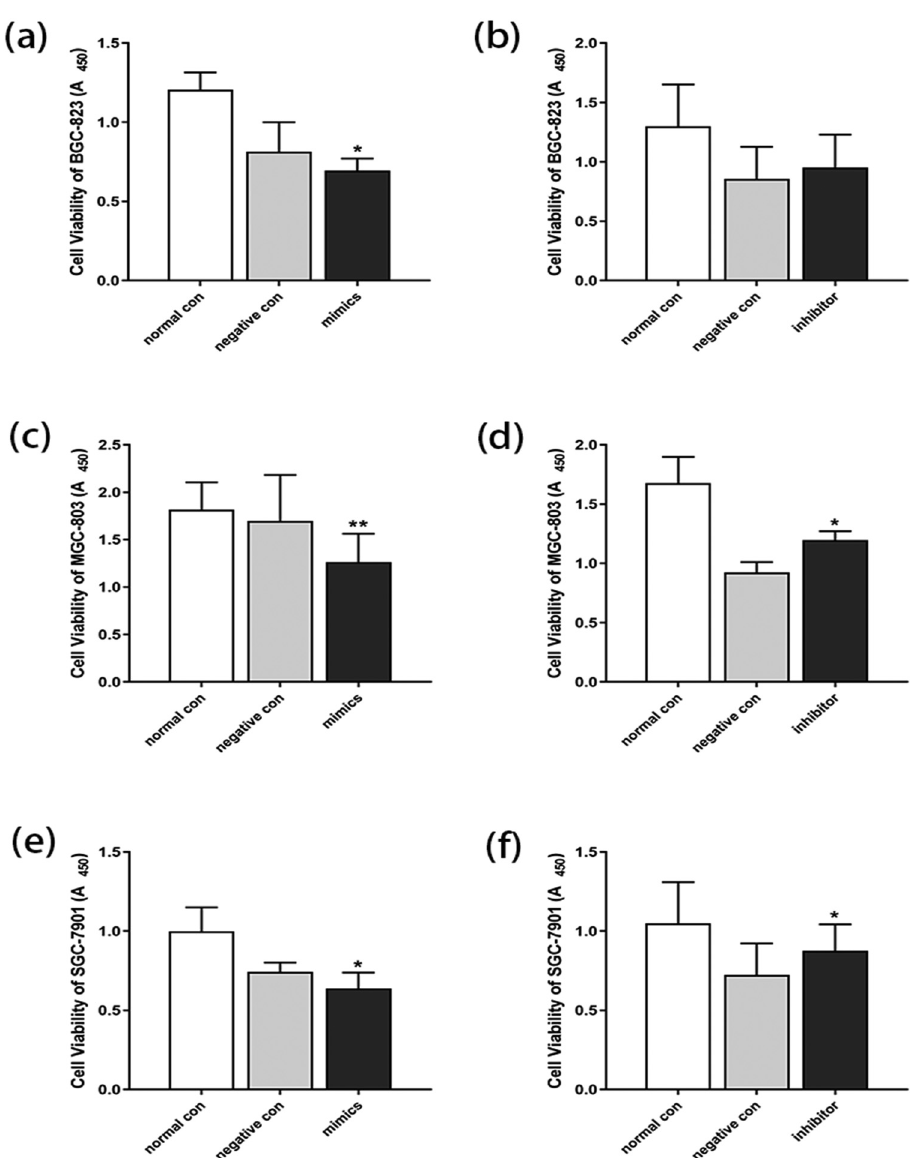
Figure 2: Impact of miR - 1273h - 5p on GC cell viability. ( a and b ) Impact of miR - 1273h - 5p on the proliferation of BGC - 823 cells at 24 h after transfection evaluated by CCK - 8 assay. Compared to the negative control, the mimic group signi fi cantly decreased. ( c and d ) E ff ect of miR - 1273h - 5p on the proliferation of MGC - 803 cells at 24 h after transfection evaluated using CCK - 8 assay. Compared to negative control group, the proliferation in the mimic group decreased while it increased in the inhibitor group. ( e and f ) E ff ect of miR - 1273h - 5p on the proliferation of SGC - 7901 cells at 24 h after transfection evaluated using CCK - 8 assay. The mimic group signi fi cantly decreased compared to negative control. The inhibitor group had a signi fi cant increase in comparison with negative group. All data were expressed as mean ± standard deviation ( M ± SD ) from three independent experiments compared with the negative control group, * P < 0.05, ** P <